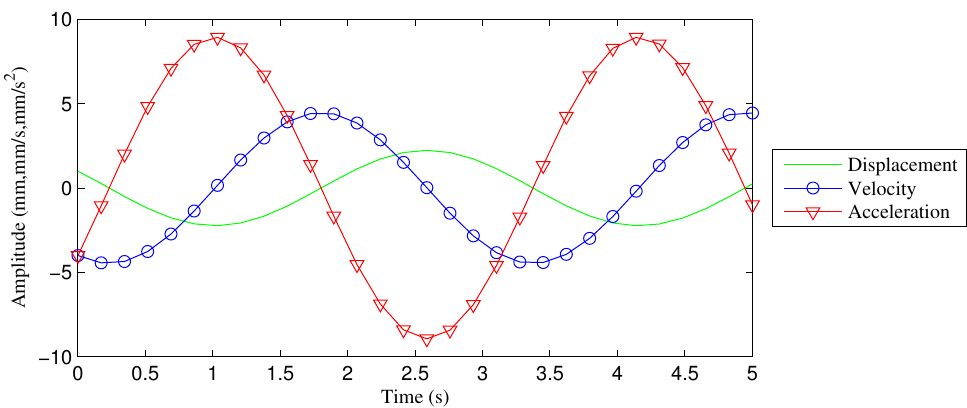
Figure 4. Displacement, velocity and acceleration for the function: x = sin ( 2 t + φ ) .